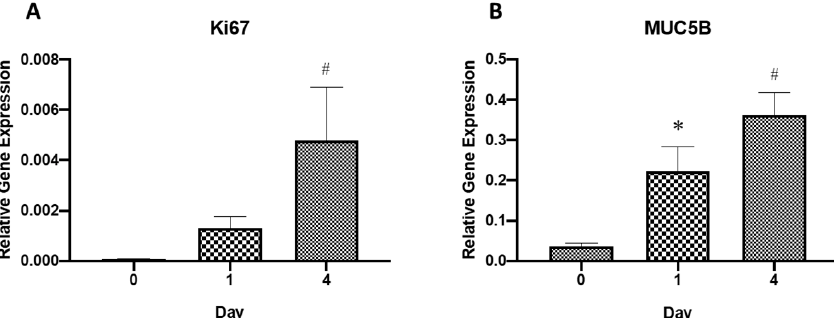
Figure 3. Relative gene expression level of Ki67 ( A ) and MUC5B ( B ) genes in cultured respiratory epithelial cells within the human-tissue-engineered respiratory epithelial construct at day 0, 1 and 4. The gene expression levels were normalized against the housekeeping gene, GAPDH. Values are presented as mean ± standard error of mean. Student’s t -test was used to compare the data between the groups, and p < 0.05 was considered statistically significant. * p < 0.05; compared values of human-tissue-engineered respiratory epithelial construct at day 0 and 1 and # p < 0.05; compared values of human-tissue-engineered respiratory epithelial construct at day 0 and